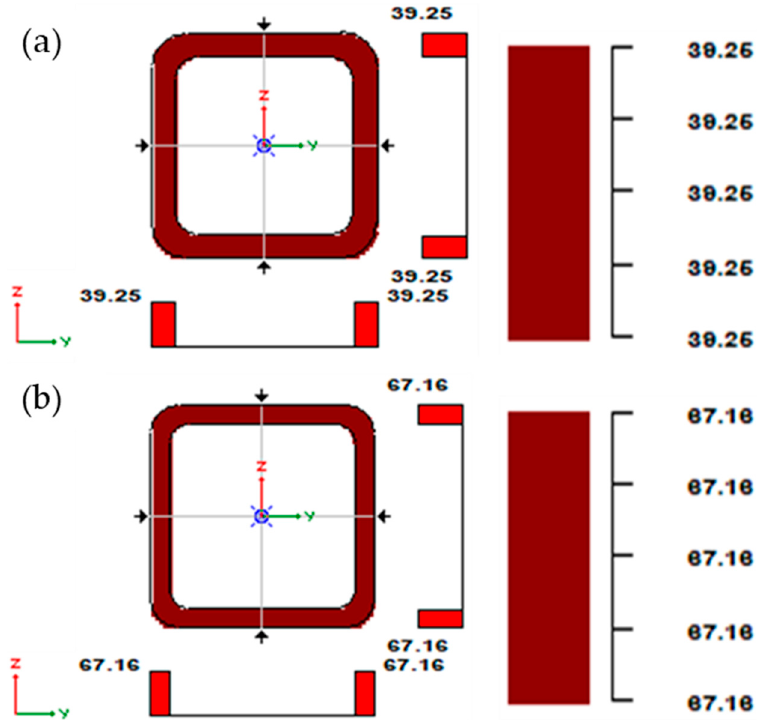
Figure 12. Stresses in the cross-section: ( a ) meridian, ( b ) parallel.